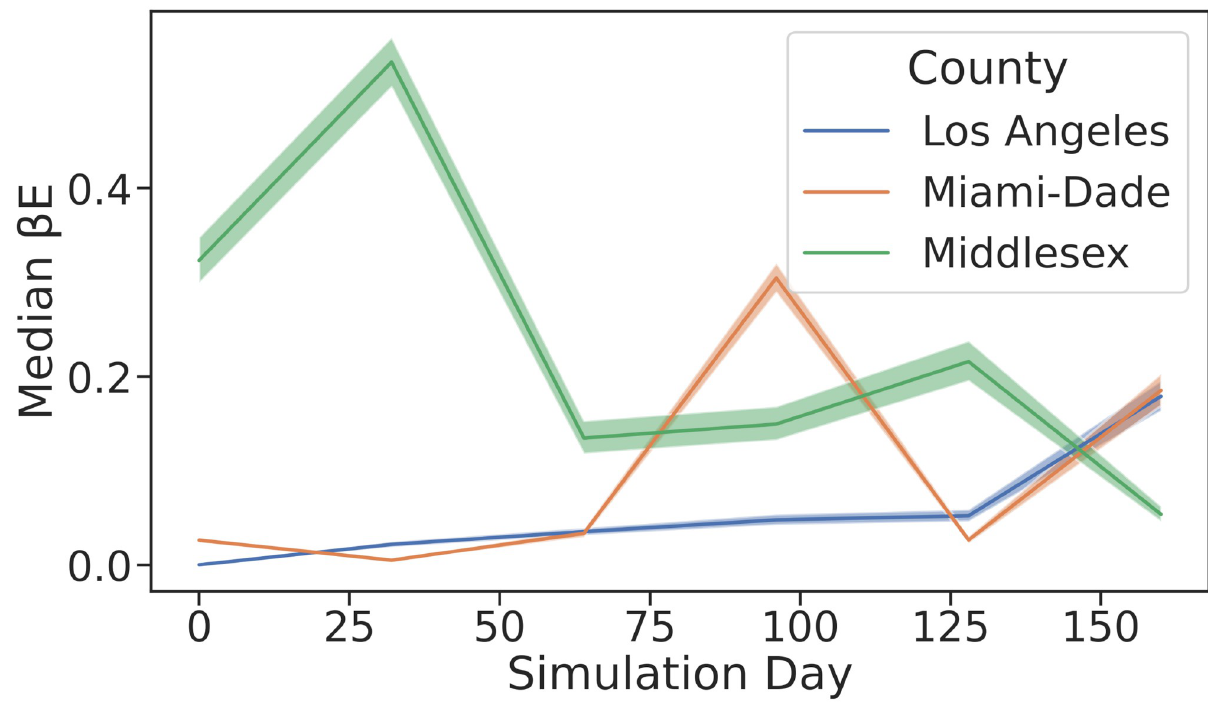
Fig 7. Median values of b t time to match the regional case counts; for example, in Middlesex county, our model infers high early values for β